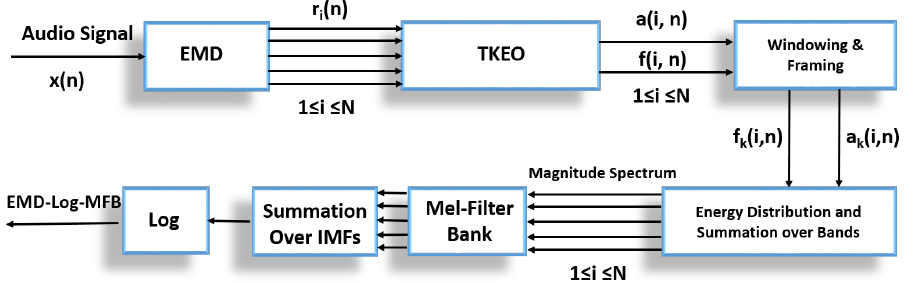
Figure 5. Empirical mode decomposition-based Mel filter bank energies extraction block diagram.